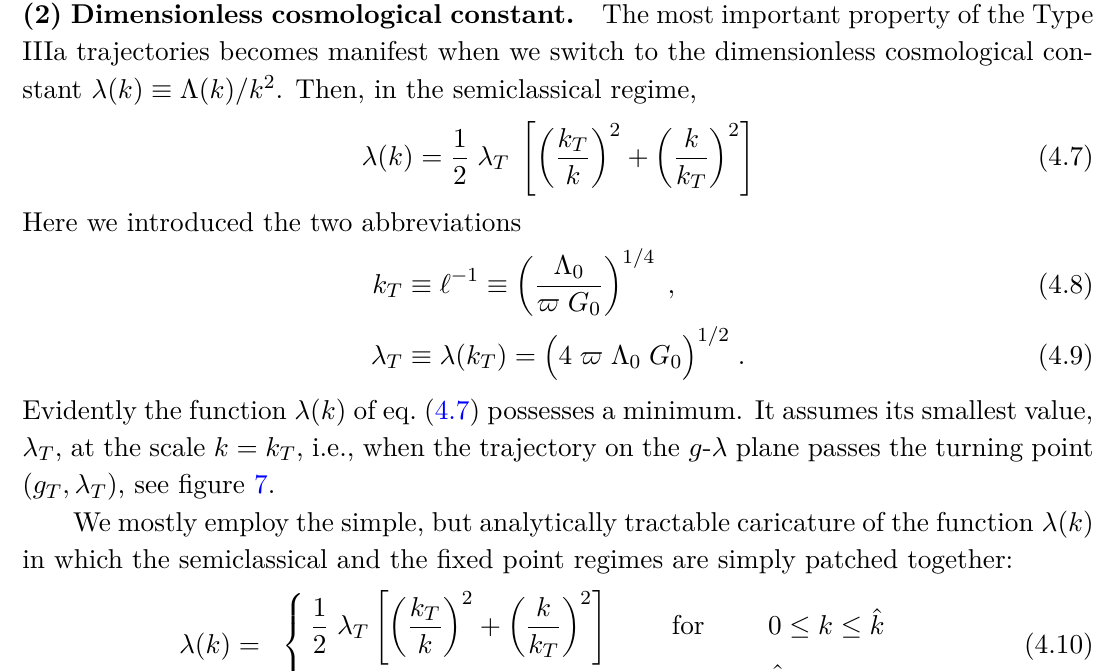
, at which λ assumes the same value. 1